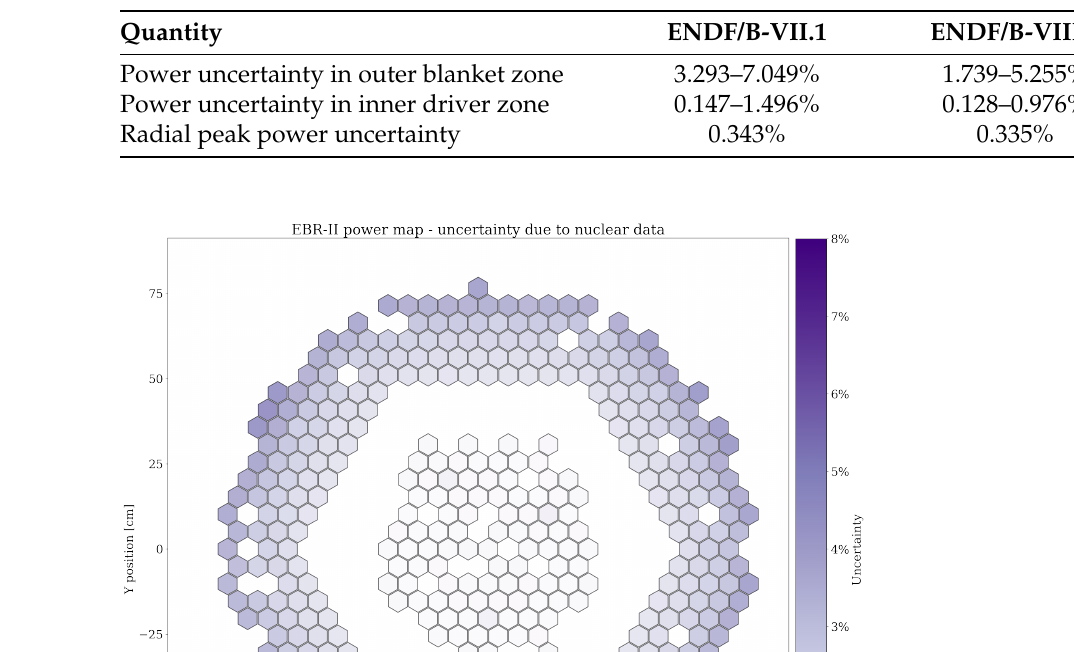
Table 9. Power uncertainties determined with Sampler/KENO-MG.